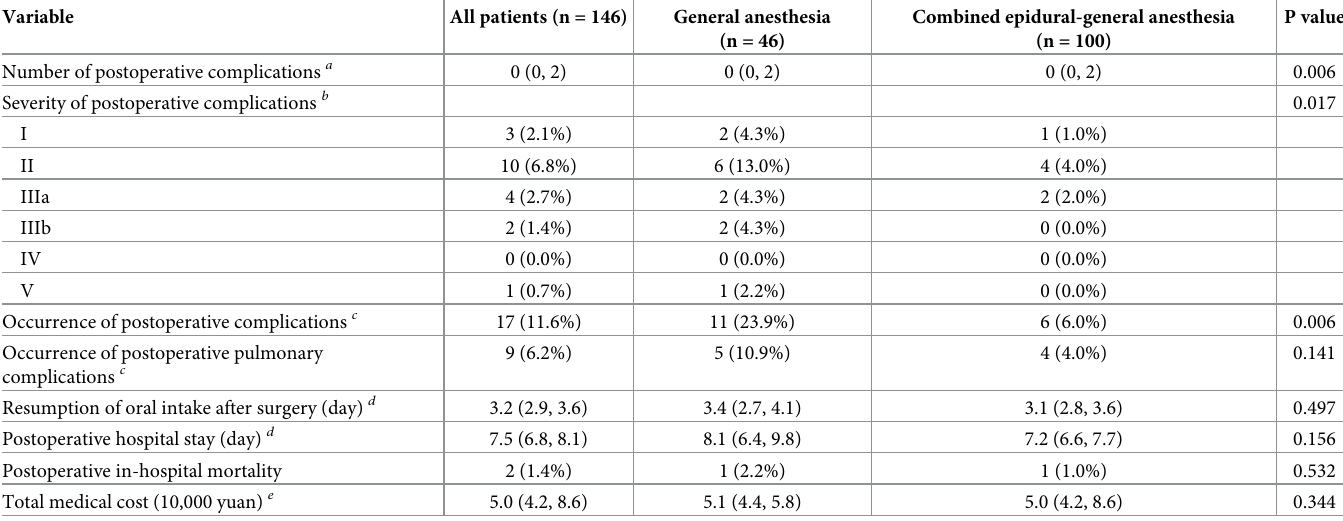
Table 3. Postoperative